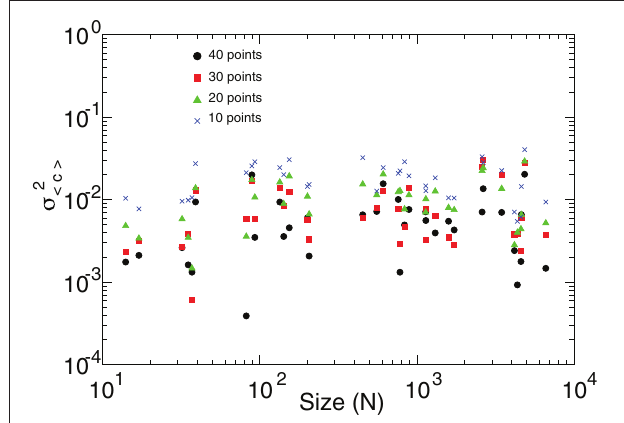
FIGURE A1 | The variance of the mean short-term spatial correlation (cid:2) C (cid:3) (already shown in Figure 4) is independent of the cluster’ sizes N regardless of the window length (10–40 time steps) at which it is